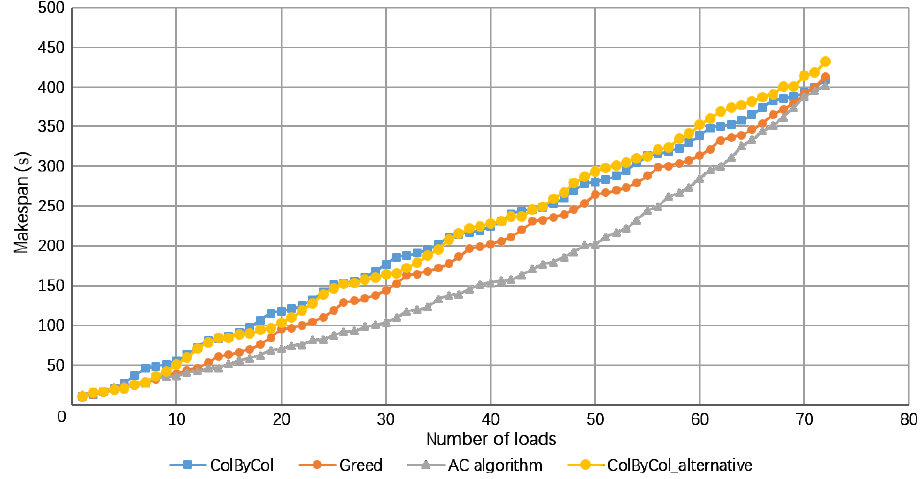
Fig. 10 Makespan of empirical rules, greed rule, and AC algorithm under six tiers and six columns model.